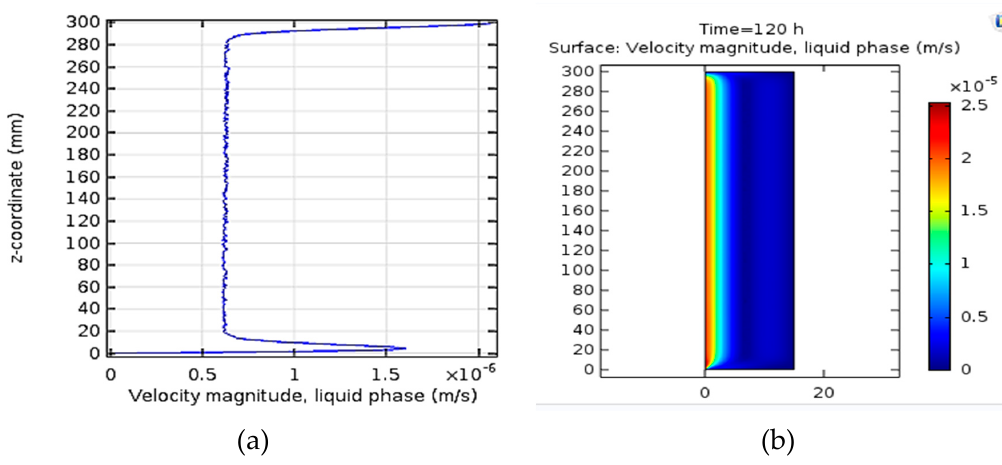
Figure 7. ( a ) Spatial changes of velocity in the liquid phase along the reactor. ( b ) Surface spatial changes of velocity in the liquid phase along the reactor.